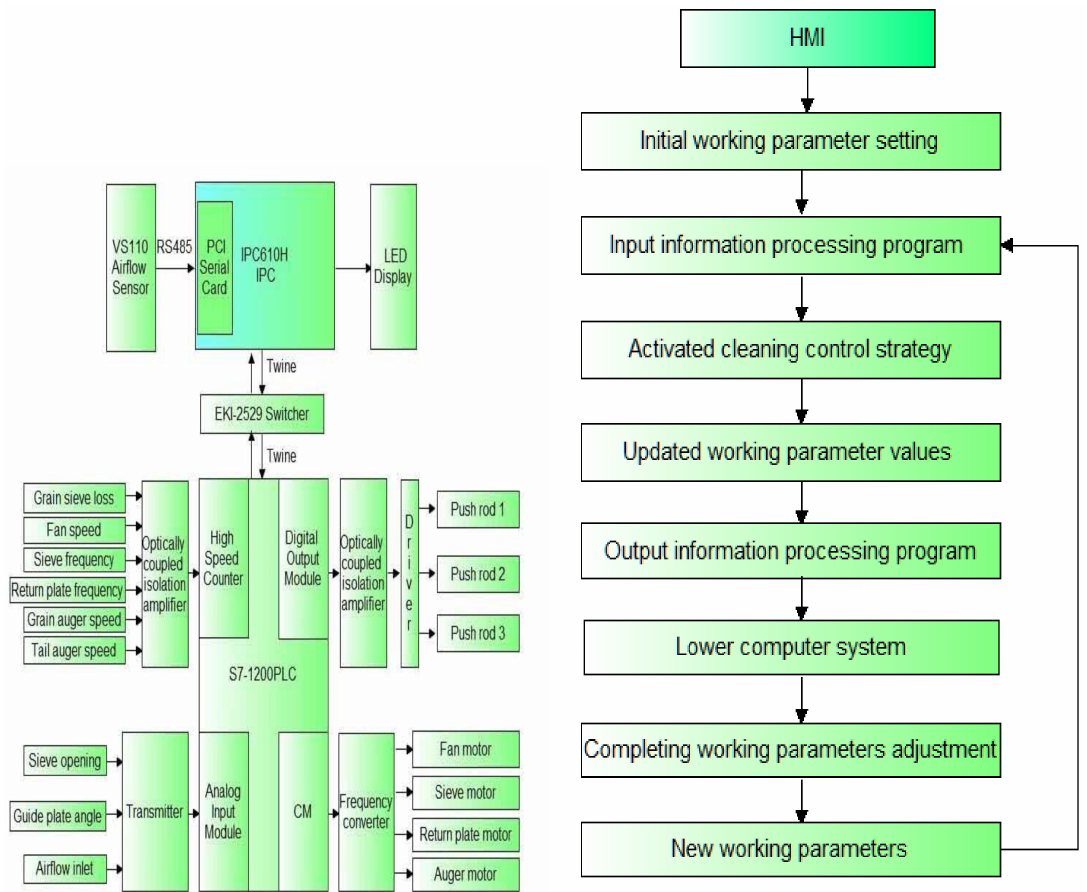
Figure 4. Hardware structure of operating monitoring and control